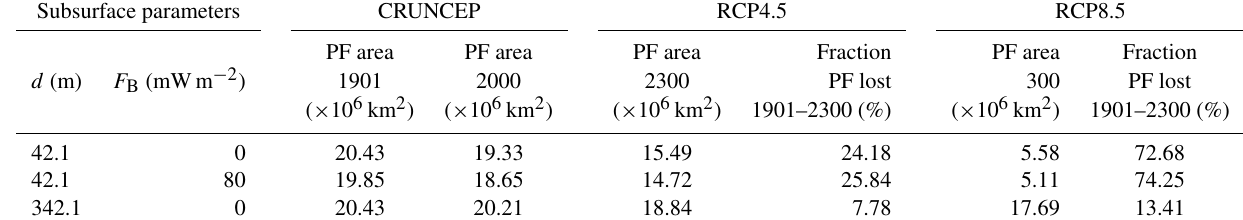
Table 3. Areal extent of intermediate-depth permafrost at 1901, 2000 and 2300CE for the RCP4.5 and RCP8.5 scenarios. Subsurface parameters